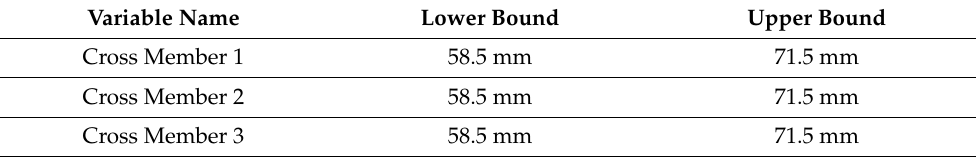
Table 2. Lower bound and upper bound values of different variables.